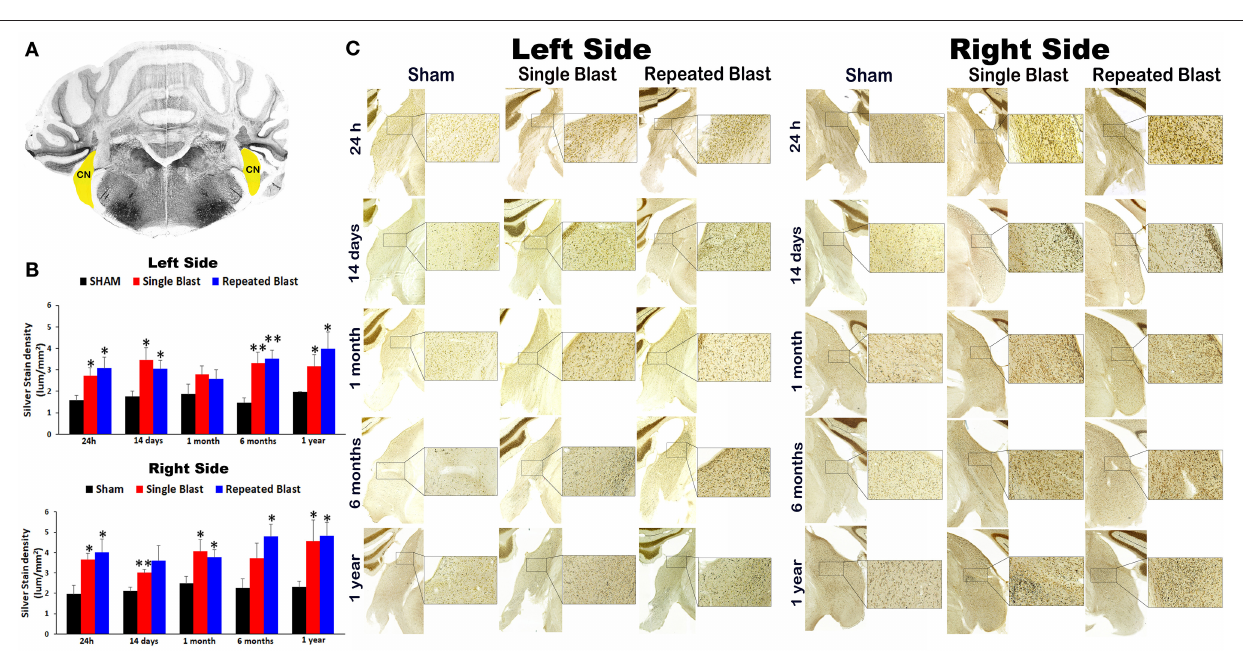
Frontiers in Neurology |